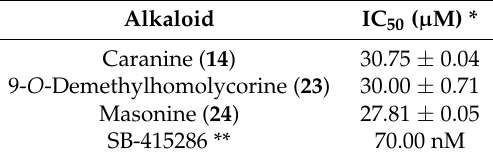
Table 2. The potency to inhibit GSK-3 β (IC 50 ) of selected Amaryllidaceae alkaloids.